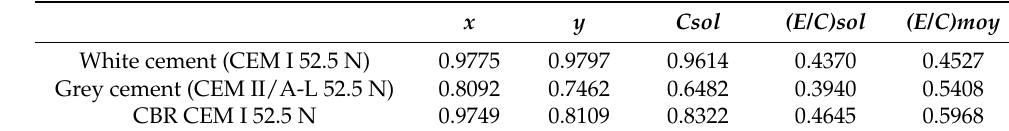
Table 6. Values needed to calculate the SFSA for the three cements.